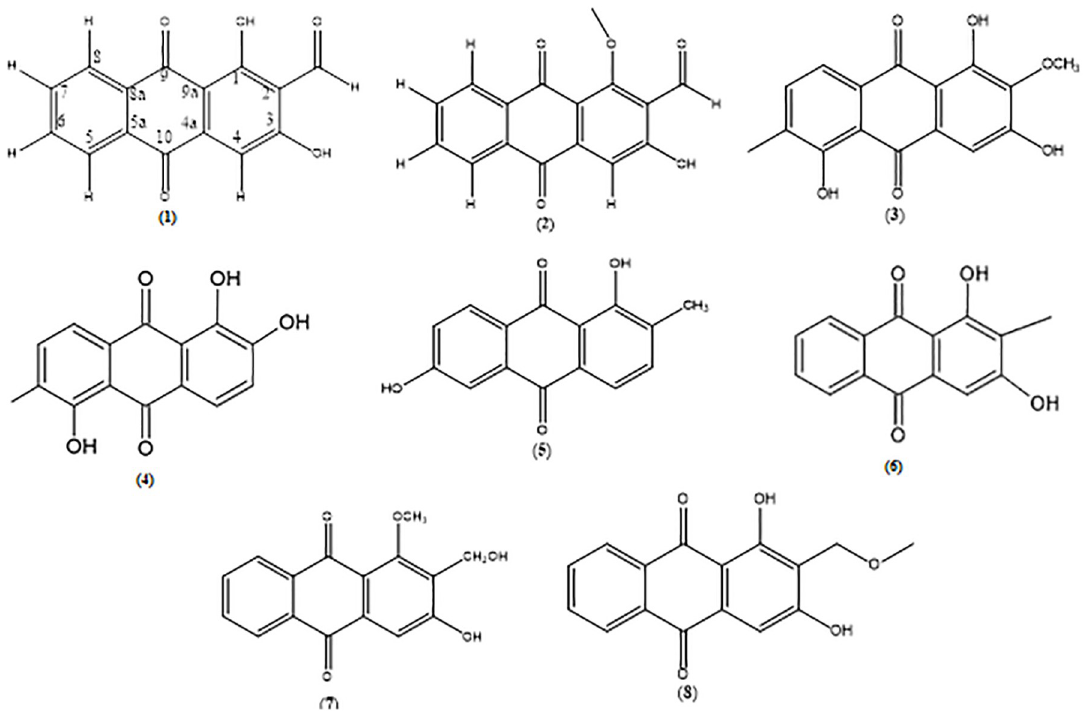
Fig 1. Chemical structure of anthraquinone compounds 1–8. (1) nordamnacanthal, (2) damnacanthal, (3) 1,3,5-dihydoxy- 2-methoxy-6-methyl anthraquinone, (4) morindone, (5) sorendidiol, (6) rubiadin, (7) damnacanthol, and (8) lucidin- ω -methylether.